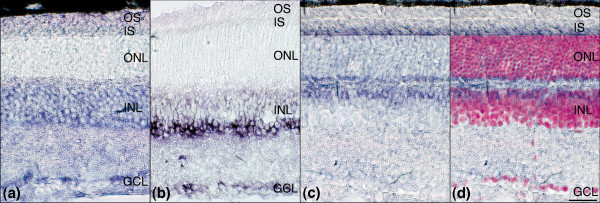
miR ISH analysis in the mouse retina. Eyes from 1-month-old c57 animals were fixed in 4% paraformaldehyde, and 12 μm cryosections were in situ hybridized with 5'-digoxigenin labeled locked nucleic acid (LNA) microRNA (miR) probes for (a) let-7, (b) miR-181a, and (c,d) miR-182. A false-colored (magenta) 4',6-diamidine-2-phenylindole-dihydrochloride (DAPI) nuclear staining is overlaid on the miR-182 in situ hybridization (ISH) label (panel d) to indicate the position of the nuclear layers. Scale bar: 25 μm. GCL, ganglion cell layer; INL, inner nuclear layer; IS, photoreceptor inner segments; ONL, outer nuclear layer; OS, photoreceptor outer segments.